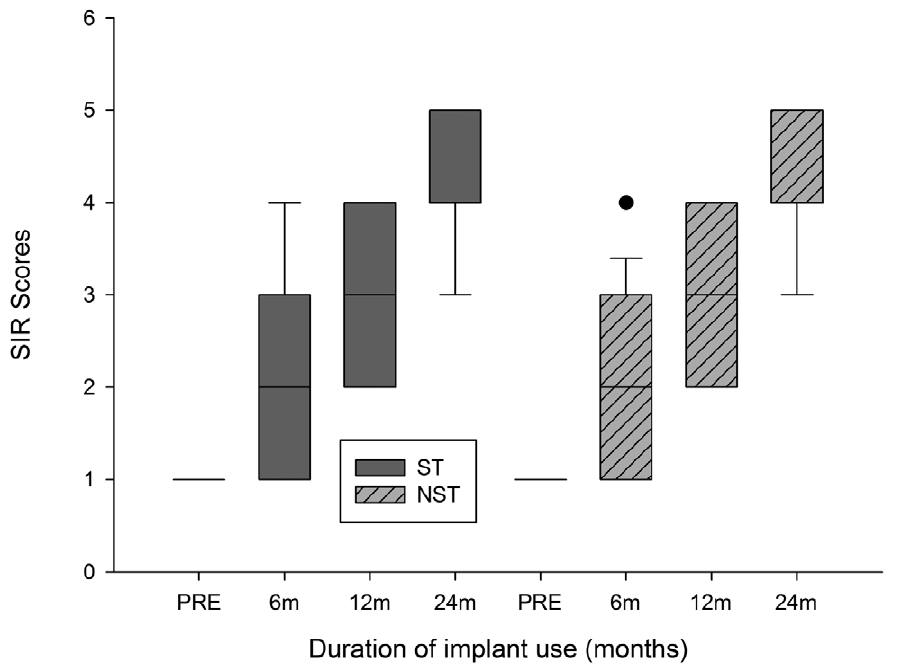
Figure 2. Box plot showing the distribution of SIR values of the two groups with the time of implant usage. Box plot explanation: upper horizontal line of box, 75th percentile; lower horizontal line of box, 25th percentile; horizontal bar within box, median; upper horizontal bar outside box, 90th percentile; lower horizontal bar outside box, 10th percentile. Circles represent outliers. doi:10.1371/journal.pone.0053852.g002 PLOS ONE |